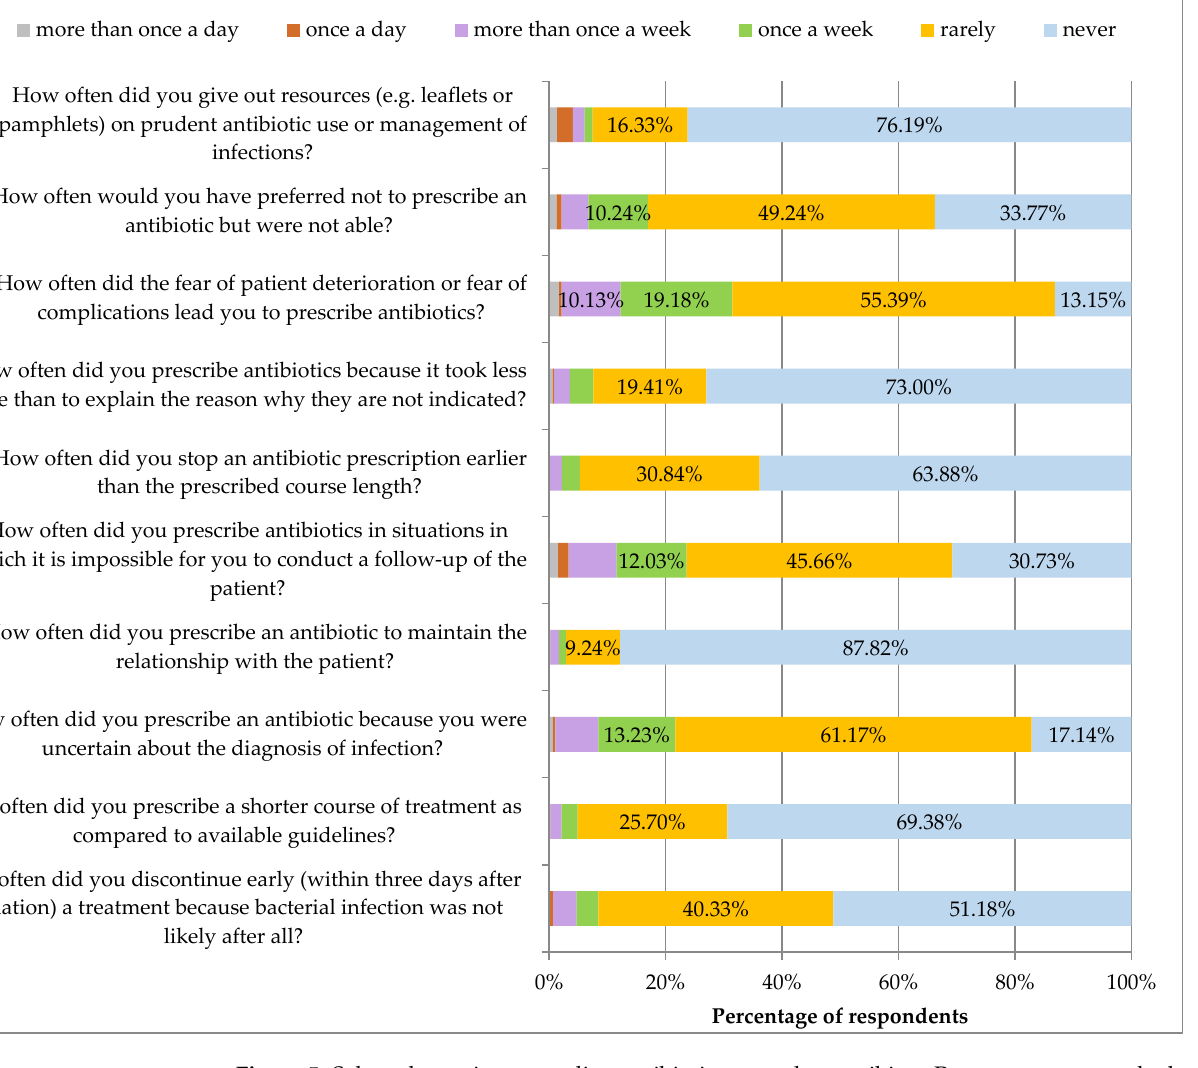
Figure 5. Selected practices regarding antibiotic use and prescribing. Percentages were calculated from the answers given.